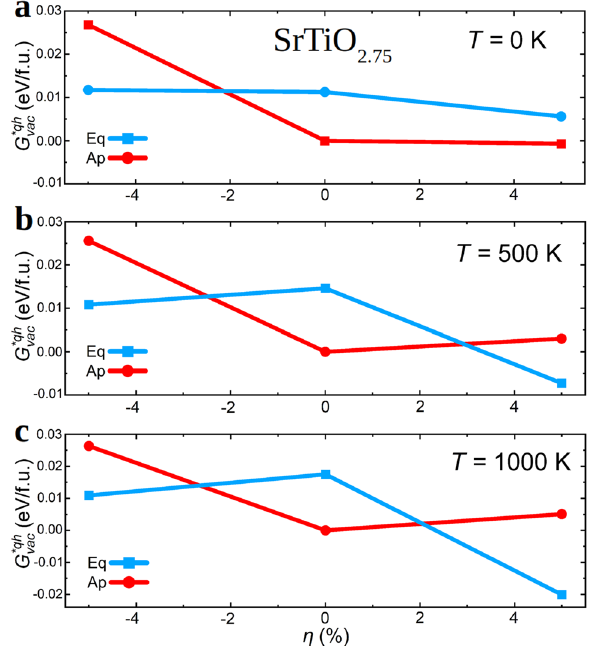
Figure 5. Thermodynamically µ O -shifted Gibbs free energy [Eqs. (2)–(4)] (“Free energy calculations” section) for V O formation expressed as a function of oxygen vacancy position, epitaxial strain and temperature. ( a ) T = 0 K, ( b ) T = 500 K, and ( c ) T = 1000 K. The composition of the off-stoichiometric (001) thin films corresponds to SrTiO 2.75 and labels “Eq” and “Ap” stand out for equatorial and apical oxygen vacancies, respectively. The solid lines are simply guides for the